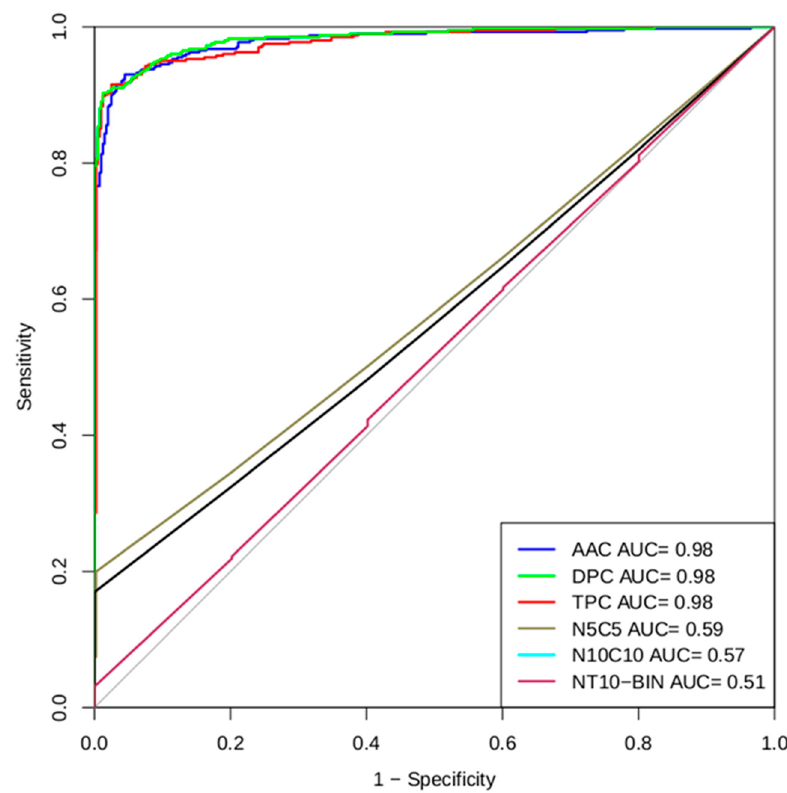
Figure 5. Multi ‐ ROC plot shows a performance of best models developed using AAC, DPC, TPC, N5C5, N10C10, and NT10-Bin peptide compositions in five-fold N5C5, N10C10, and NT10 ‐ Bin peptide compositions in five ‐ fold cross ‐ validation.